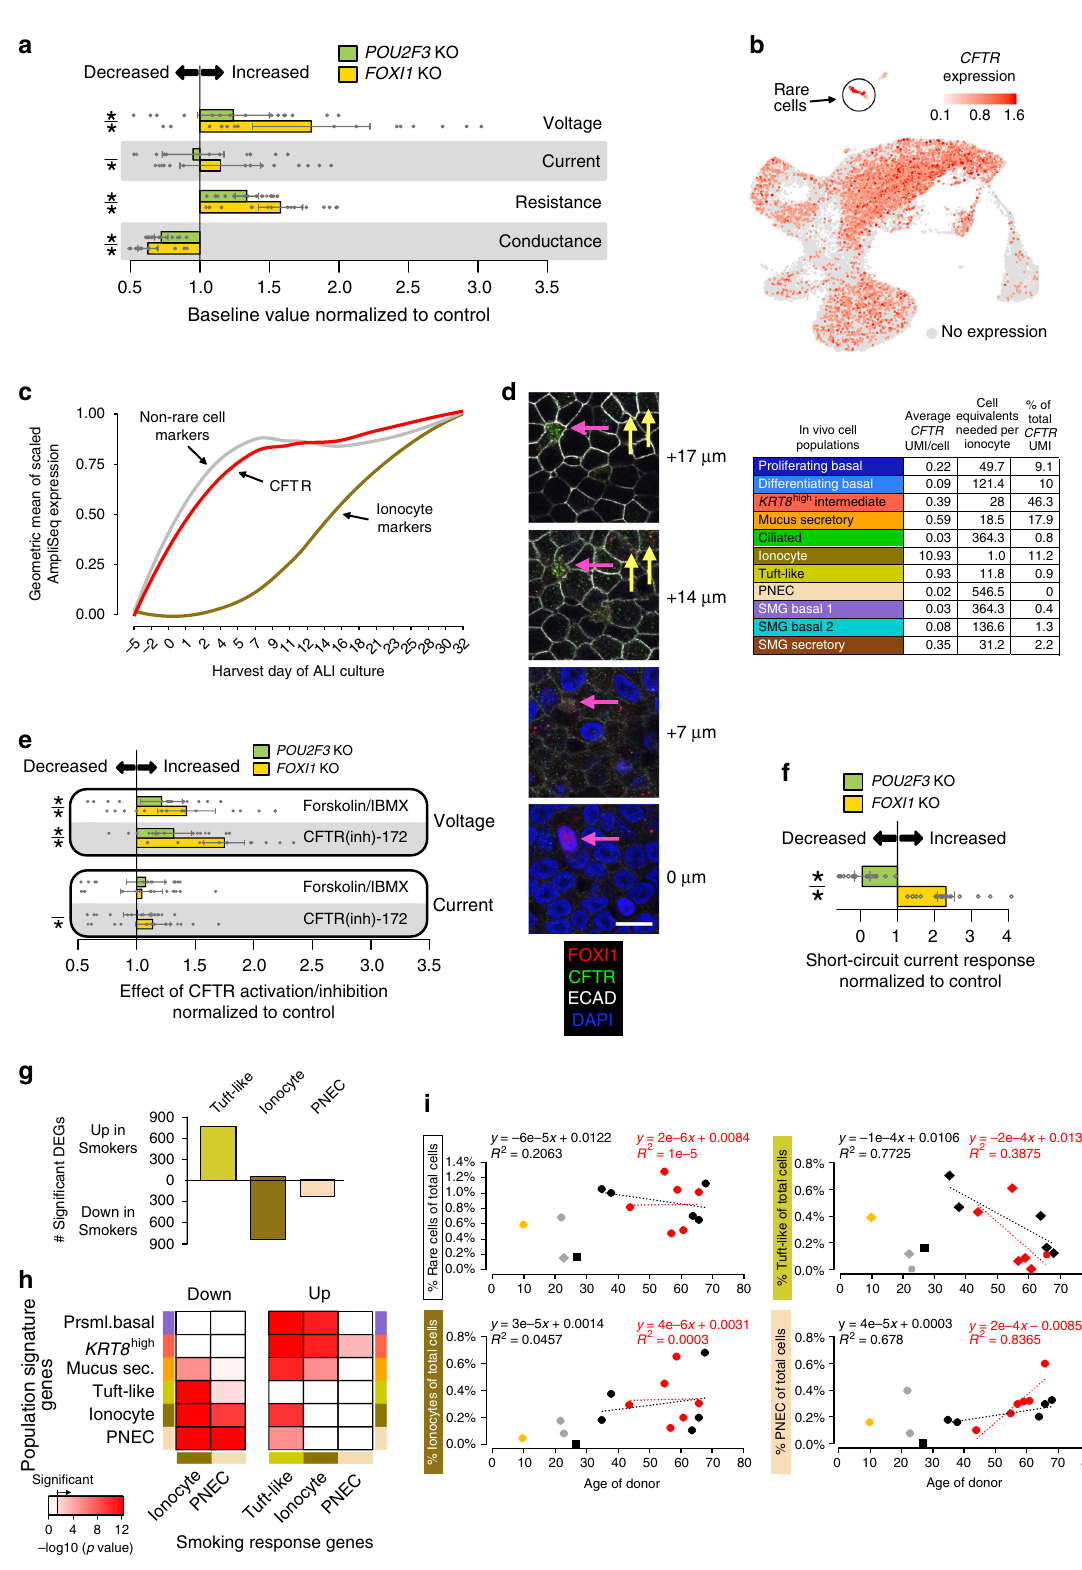
RNAScope FISH (tissue and ALI section histological labeling) . Adjacent cross- sections of human trachea or PBS rinsed ALI cultures were fi xed in 10% neutral buffered formalin for 24 ± 8h at room temperature, washed with 1× PBS and paraf fi n-embedded immediately. Paraf fi n blocks were sectioned onto SuperFrost Plus slides, dried overnight, and baked for 1h at 60°C before